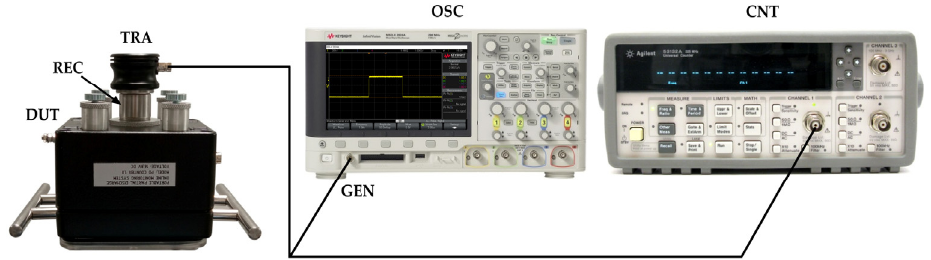
Figure 9. Schematic diagram of the measurement system for testing the efficiency of counting AE pulses by the monitoring system: TRA—wideband piezoelectric transducer Olympus V101B for generating AE pulses (transmitter), REC—piezoelectric transducer of the monitoring system (receiver), DUT—monitoring system (device under test), OSC—oscilloscope Keysight DSOX2024A, GEN—signal generator, CNT—universal counter Agilent/HP 53132A.